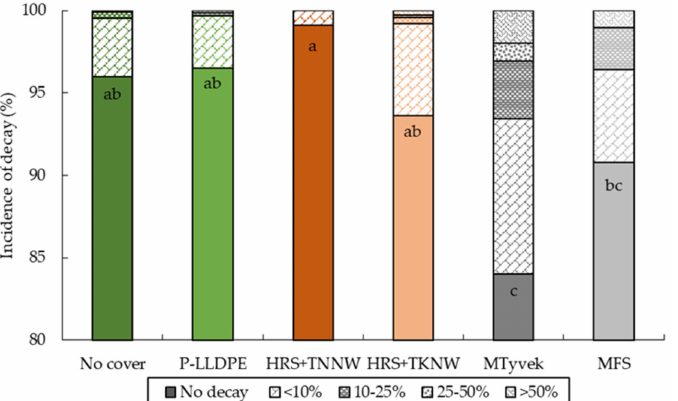
Figure 12. The percentage of decay incidence in six treatments after simulated storage at 18 ◦ C for 48 h and simulated transportation at 30 ◦ C for 15 h. No decay shown by different letters in each treatment indicates significant differences at p < 0.05 for Tukey’s HSD post hoc test. Values are mean ± S.E. from five replicates.